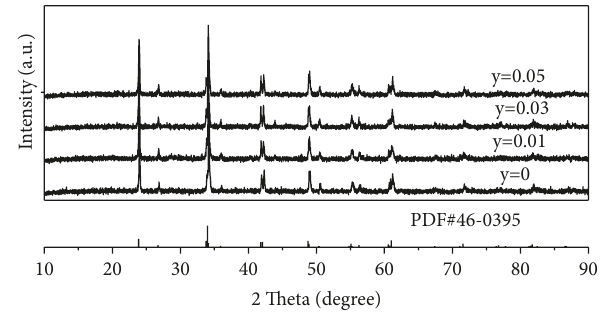
Figure 5: XRD patterns of (Gd 0.91 phosphors.